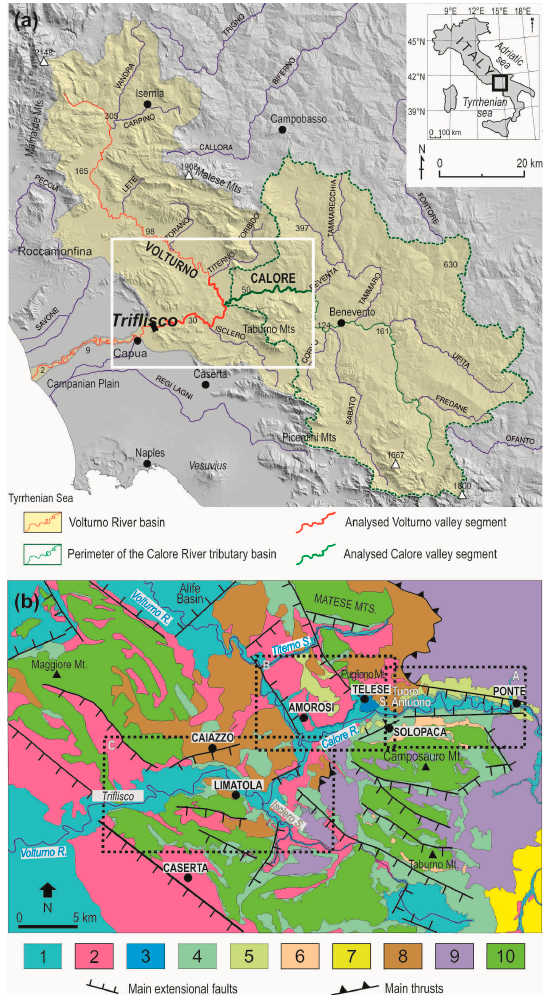
Figure 1. ( a ) The Volturno River basin and the analyzed segments of the Volturno and Calore valleys; ( b ) geological sketch map of the sector of the southern Apennine chain including the middle Volturno and lower Calore valleys. For location and limits, see the white box in ( a ). In dashed black frames the three study sectors A, B, and C. Legend: (1) Alluvial and lacustrine deposits (Upper Pleistocene– Recent); (2) Volcanic deposits (Upper Pleistocene–Holocene); (3) Travertines (Upper Pleistocene– Holocene?); (4) Eluvial-colluvial, slope, and alluvial fan deposits (Middle Pleistocene–Holocene); (5) Alluvial deposits (Middle–Upper Pleistocene); (6) Slope breccias of Laiano Synthem (Lower Pleistocene); (7) Sands, clays and conglomerates of Ariano Unit (Pliocene); (8) Siliciclastic deposits of Molise and Caiazzo Flysch (Upper Miocene); (9) Varicoloured clays, limestones, marls, and arenites of Sannio Units (Upper Cretaceous–Miocene); (10) Limestones and dolostones of Carbonate Platform Units